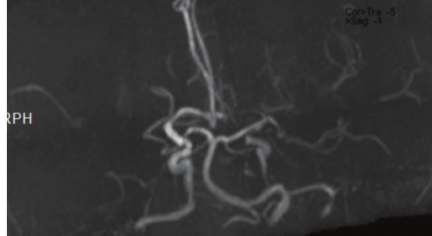
Figure 3: Cranial TOF MRA reveals bilateral occluded middle cerebral